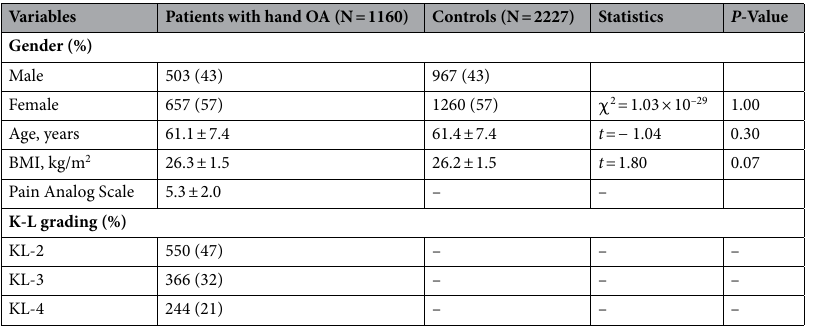
Table 1. Characteristics and demographic information of the study subjects. Continuous variables were presented by mean ± standard